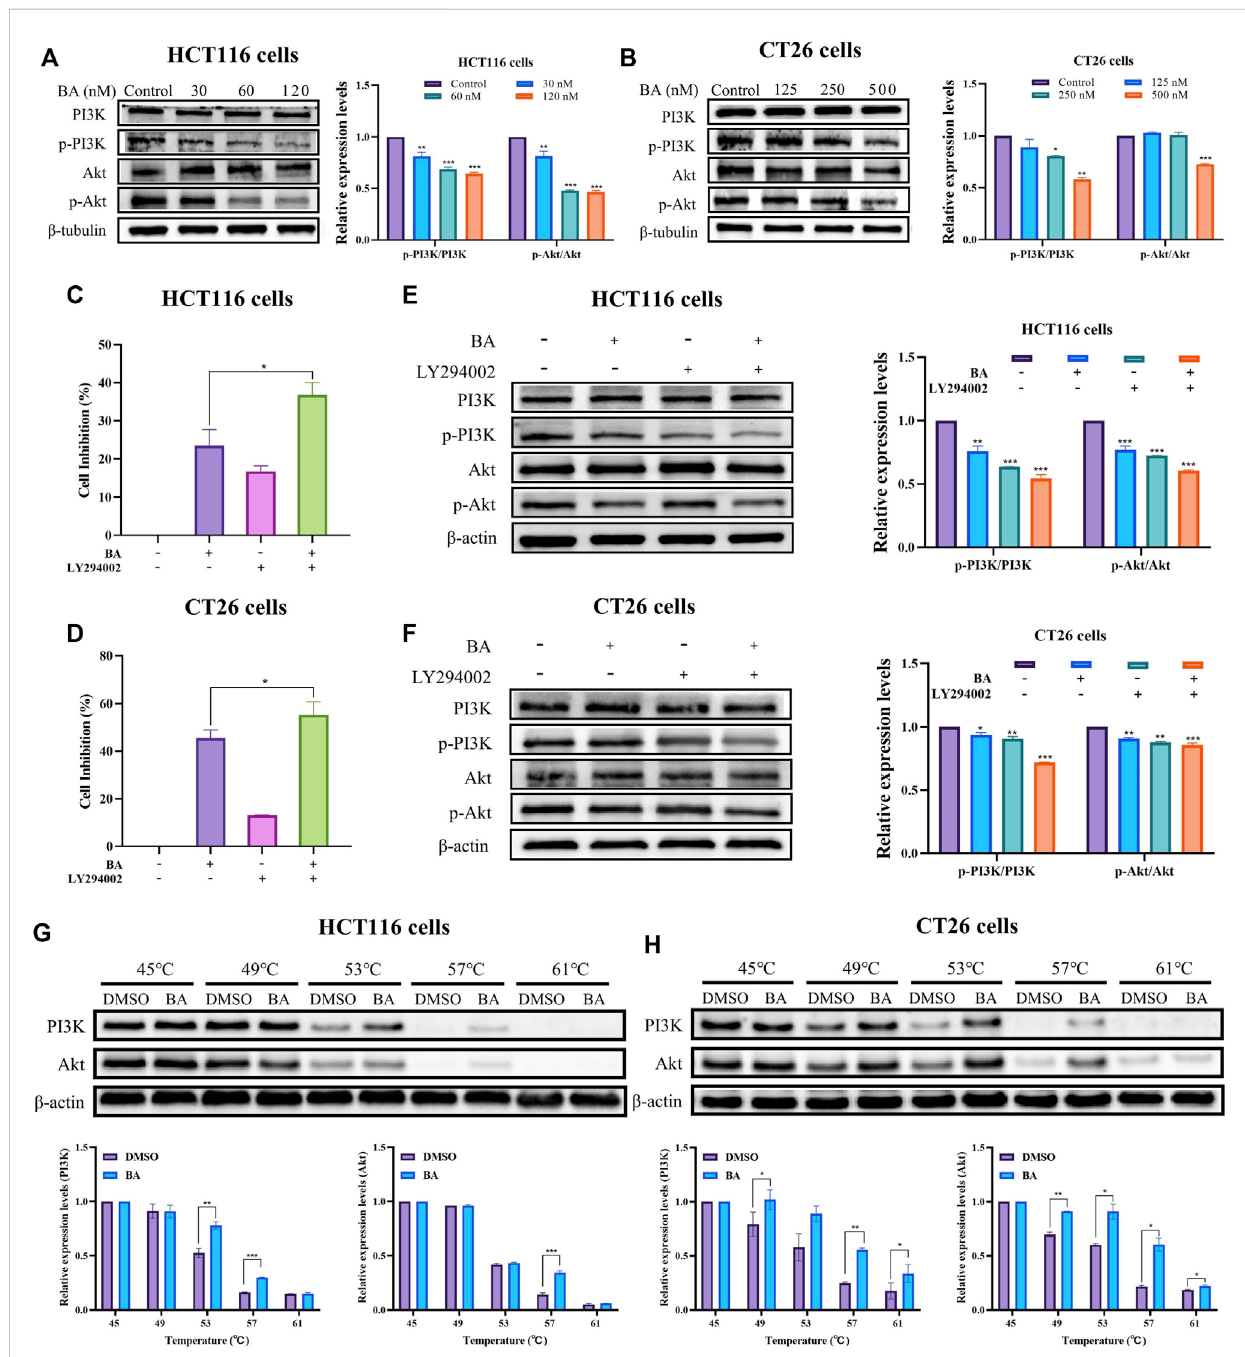
FIGURE 8 BA inhibited the PI3K/Akt signaling pathway. (A,B) The PI3K/Akt pathway related protein expression levels of HCT116 (A) and CT26 (B) cells treated with BA were measured by western blot, and β -tubulin served as a loading control. (C,D) The cell inhibition rate of HCT116 (C) and CT26 (D) cells were treated with BA and/or LY294002 for 48 h (E,F) The PI3K/Akt pathway related protein expression levels of HCT116 (E) and CT26 (F) cells treated with BA and/or 2 LY294002 (20 μ M) were measured by western blot, and β -tubulin or β -actin served as a loading control. (G,H) Western blotting intensity and standardized statistics of PI3K and Akt in HCT116 (G) and CT26 (H) cells with or without BA in CETSA test. * p < 0.05, ** p < 0.01, *** p < 0.001, compared to the control